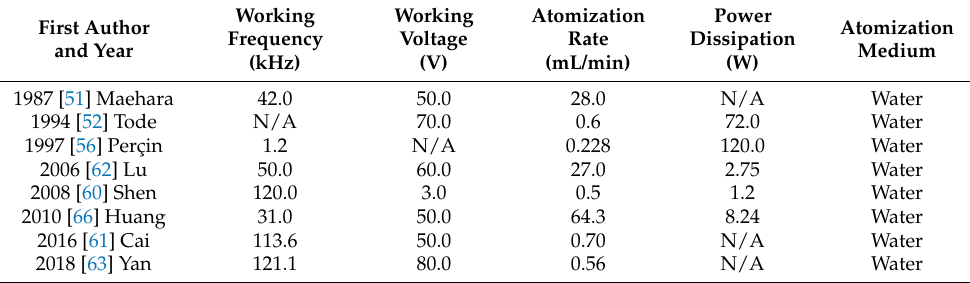
Table 3. Summary of properties for the dynamic mesh